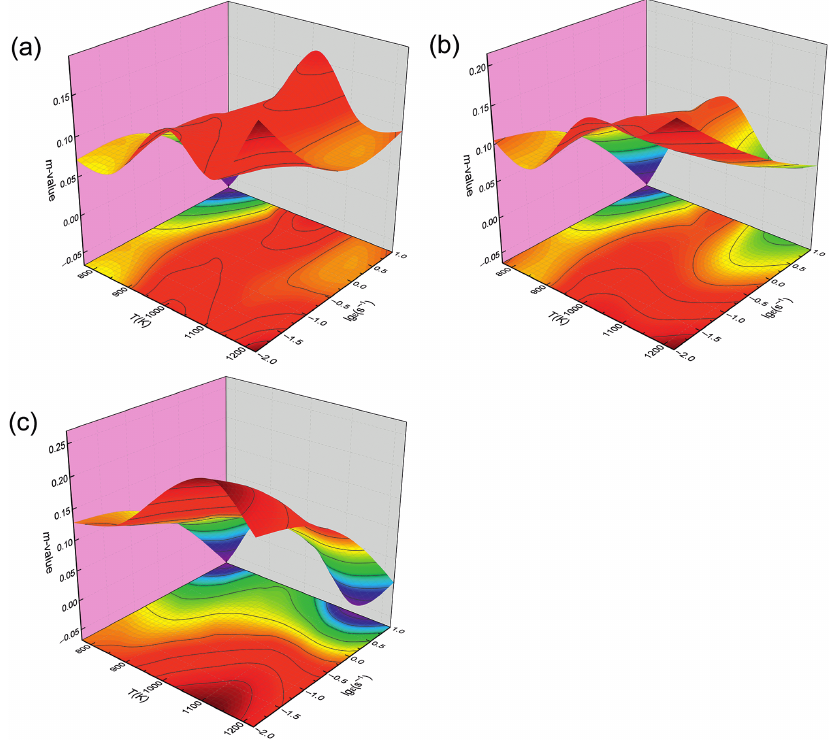
Figure 6: The 3D response surface of m -value on strain rate and temperature under different strains: (a) ε = 0.05, (b) ε = 0.10, (c) ε =